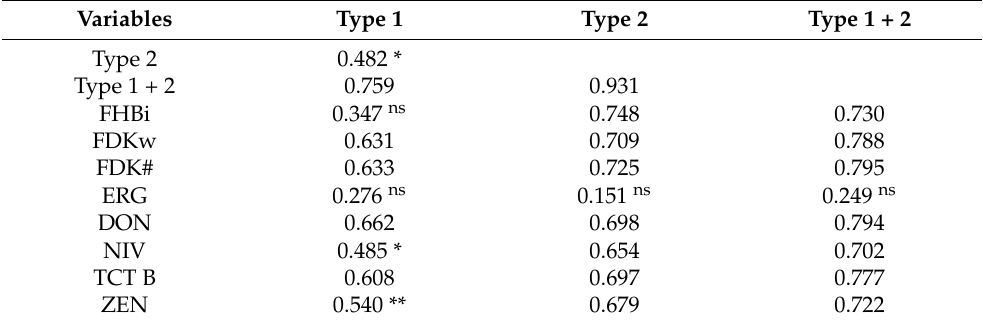
Table 10. Coefficients of correlation between type 1 and type resistances and Fusarium head blight index, Fusarium -damaged kernels proportion (weight, number) and concentration of ergosterol and mycotoxins in grain of 15 winter triticale and three winter wheat